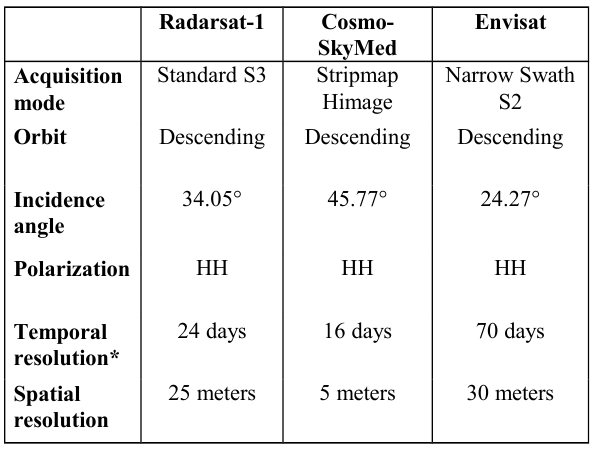
Table 3. Dataset characteristics (*mean value)